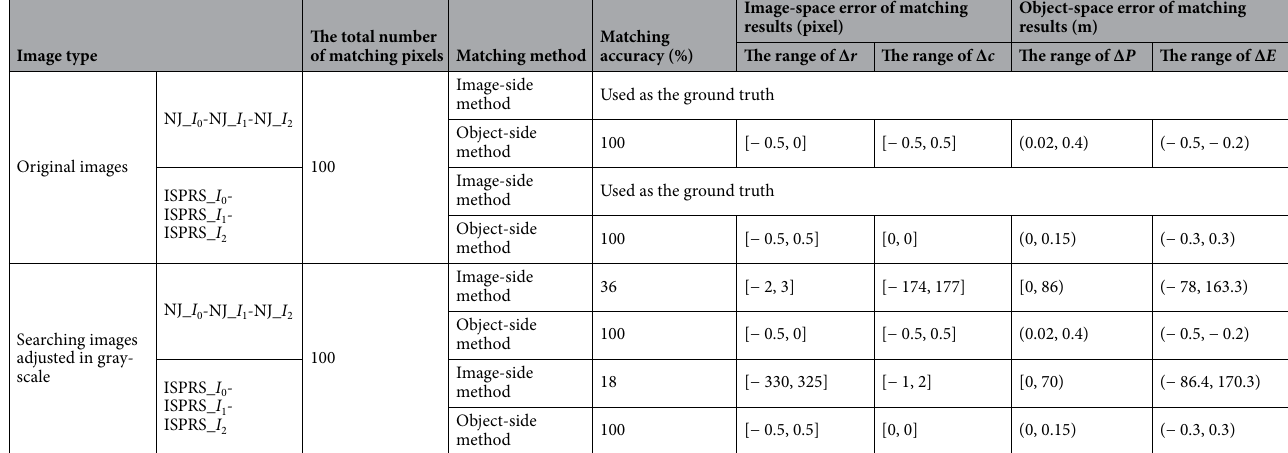
Table 3. Quantitative comparison results of object-side and image-side multi-view matching methods in image matching for two types of experimental